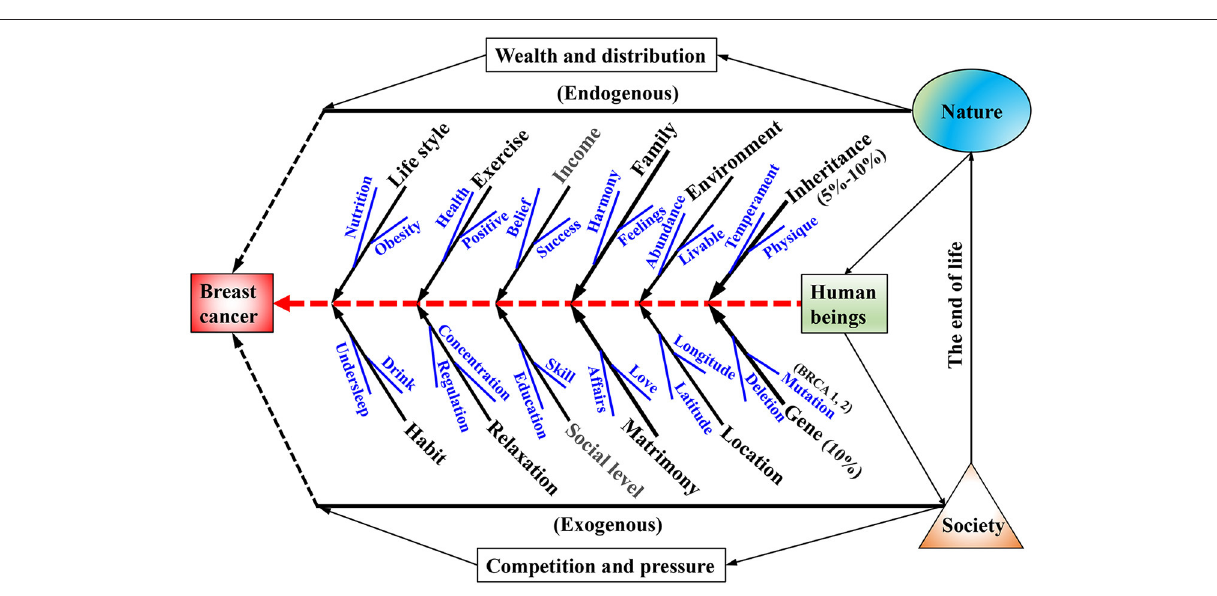
might be fitted discretely in the curve of UR-incidence and mortality of breast cancer. However, the effects of unemployment are clear. Our results are broadly consistent with literature (55), unemployment significantly increases the risk of being dead at the end of follow-up by nearly 50%. The fact may ask for the deep think on the unemployment insurance system for the potential protective effects on the patients of breast cancer (50).